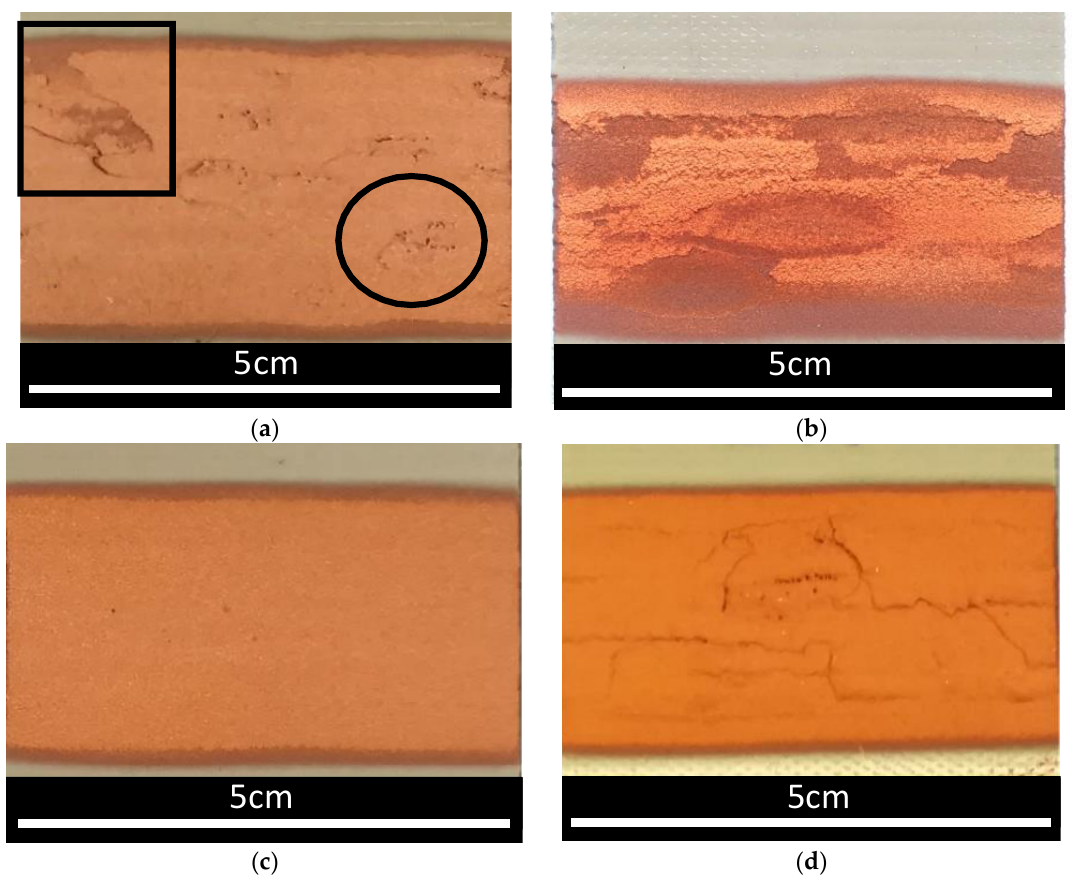
Figure 3. Coatings obtained with deposition sets V1 ( a ), V2 ( b ), V3 ( c ), and V4 ( d ). Typical traces of delamination as illustrated inside the black box and black circle on the figure ( a ).